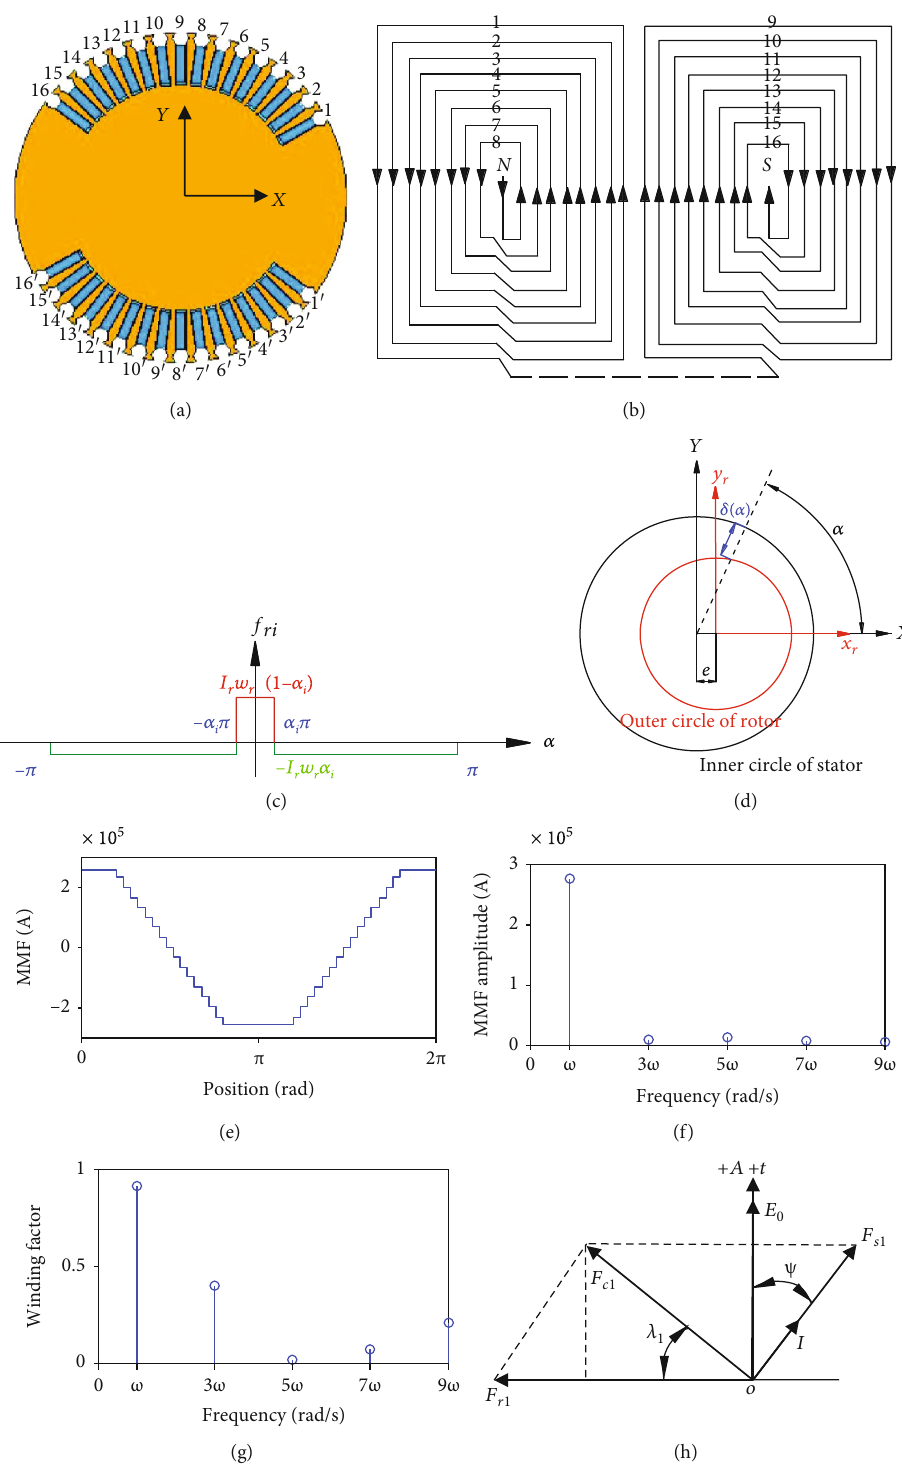
Figure 1: Air-gap and MMF: (a) sectional view of rotor winding distribution, (b) connection relationship of rotor windings, (c) MMF of the i th rotor coil, (d) eccentric air-gap, (e, f) rotor winding MMF waveform and spectrum, (g) winding factor harmonics, and (h) relationship of rotor winding MMF and stator wingding